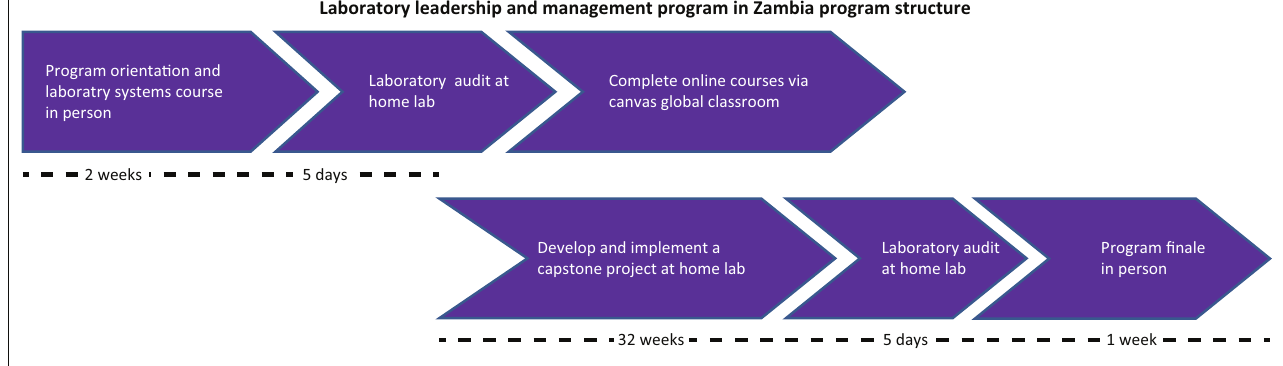
FIGURE 1: Structural overview for the laboratory leadership and management programme in Zambia, 2016–2018. Two cohorts of participants from 16 laboratories across Zambia participated from 2016–2018, each cohort taking 9 months to complete the programme work. Both programme years utilised a similar approach to adult experiential learning, utilising a blended solution of online and face-to-face instruction, a robust online discussion board as well as close faculty and mentorship support for individual capstone projects conducted at participant’s home laboratories. Orientation and finale sessions were conducted in Lusaka. Seventeen laboratory